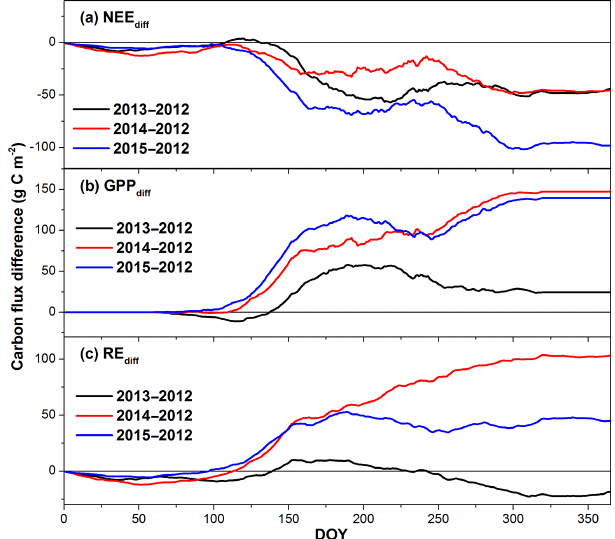
Table 6. The GPP diff for 2013–2012, 2014–2012 and 2015–2012